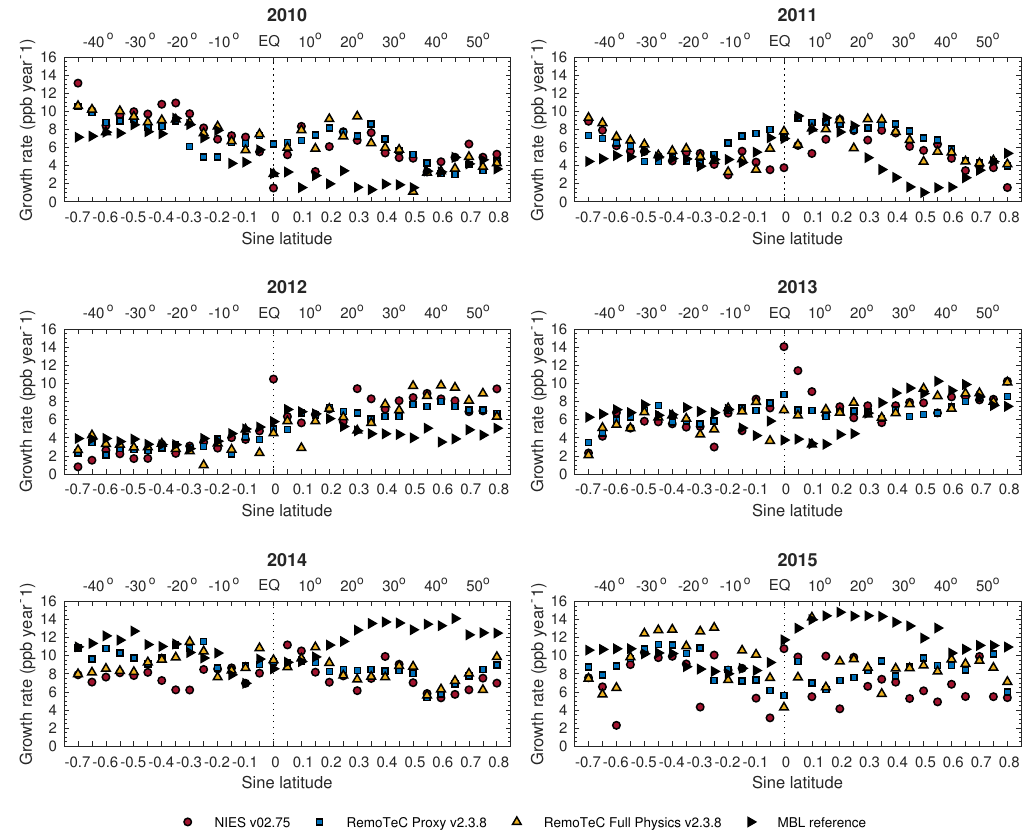
Figure 11. Yearly growth rates at each latitude band for NIES, RemoTeC Proxy and RemoTeC FP GOSAT XCH 4 retrievals and NOAA’s MBL reference